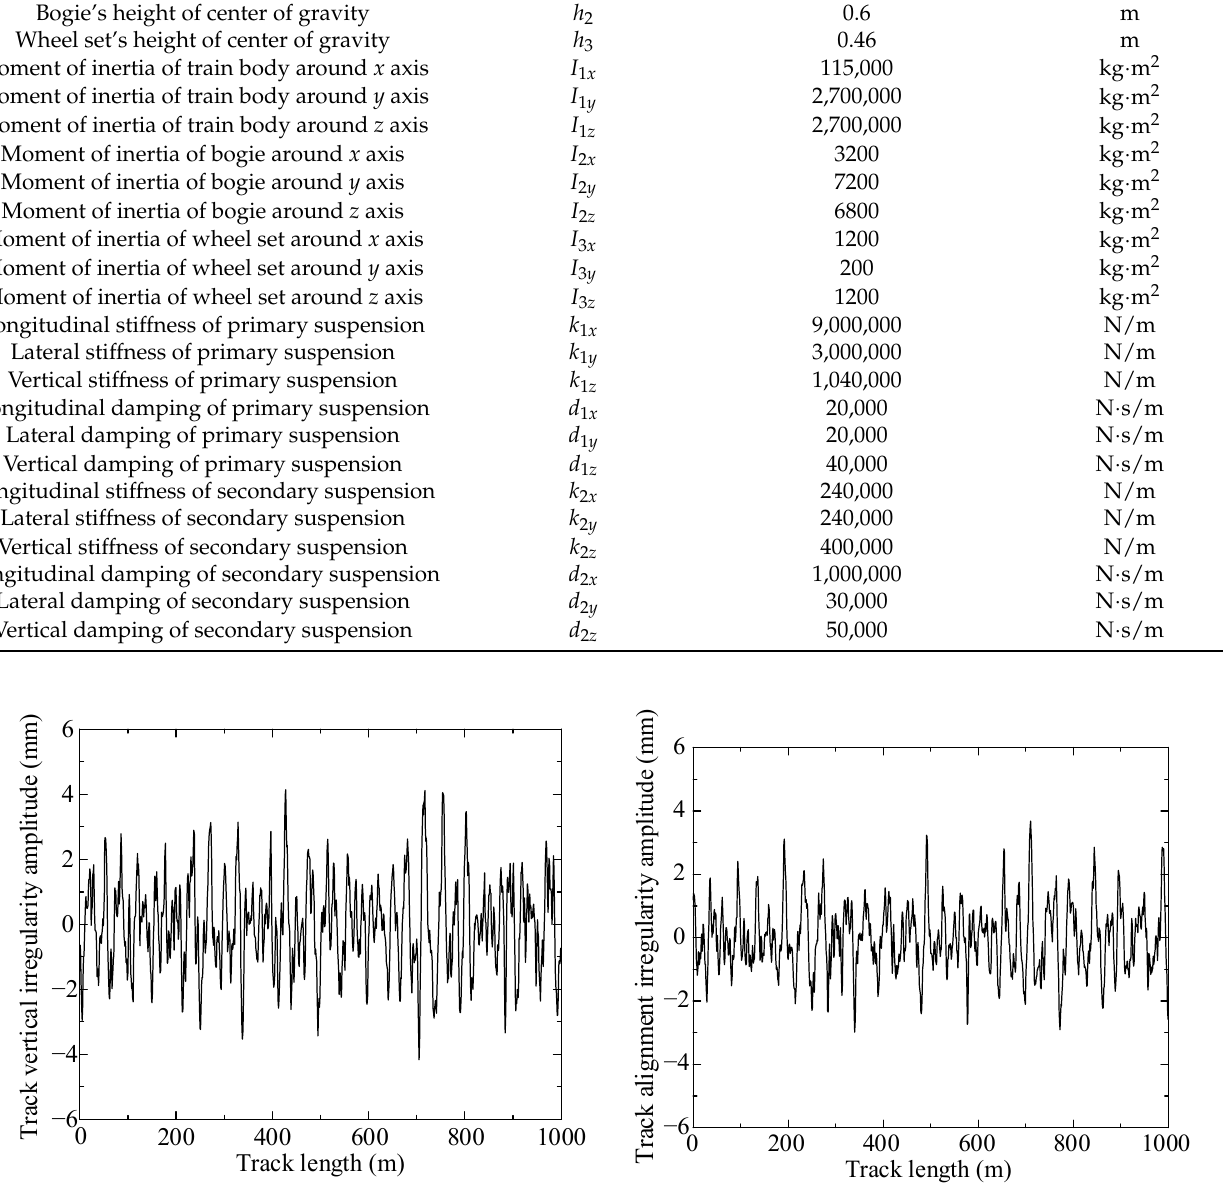
Figure 20. Spectrum of low interference track irregularities.